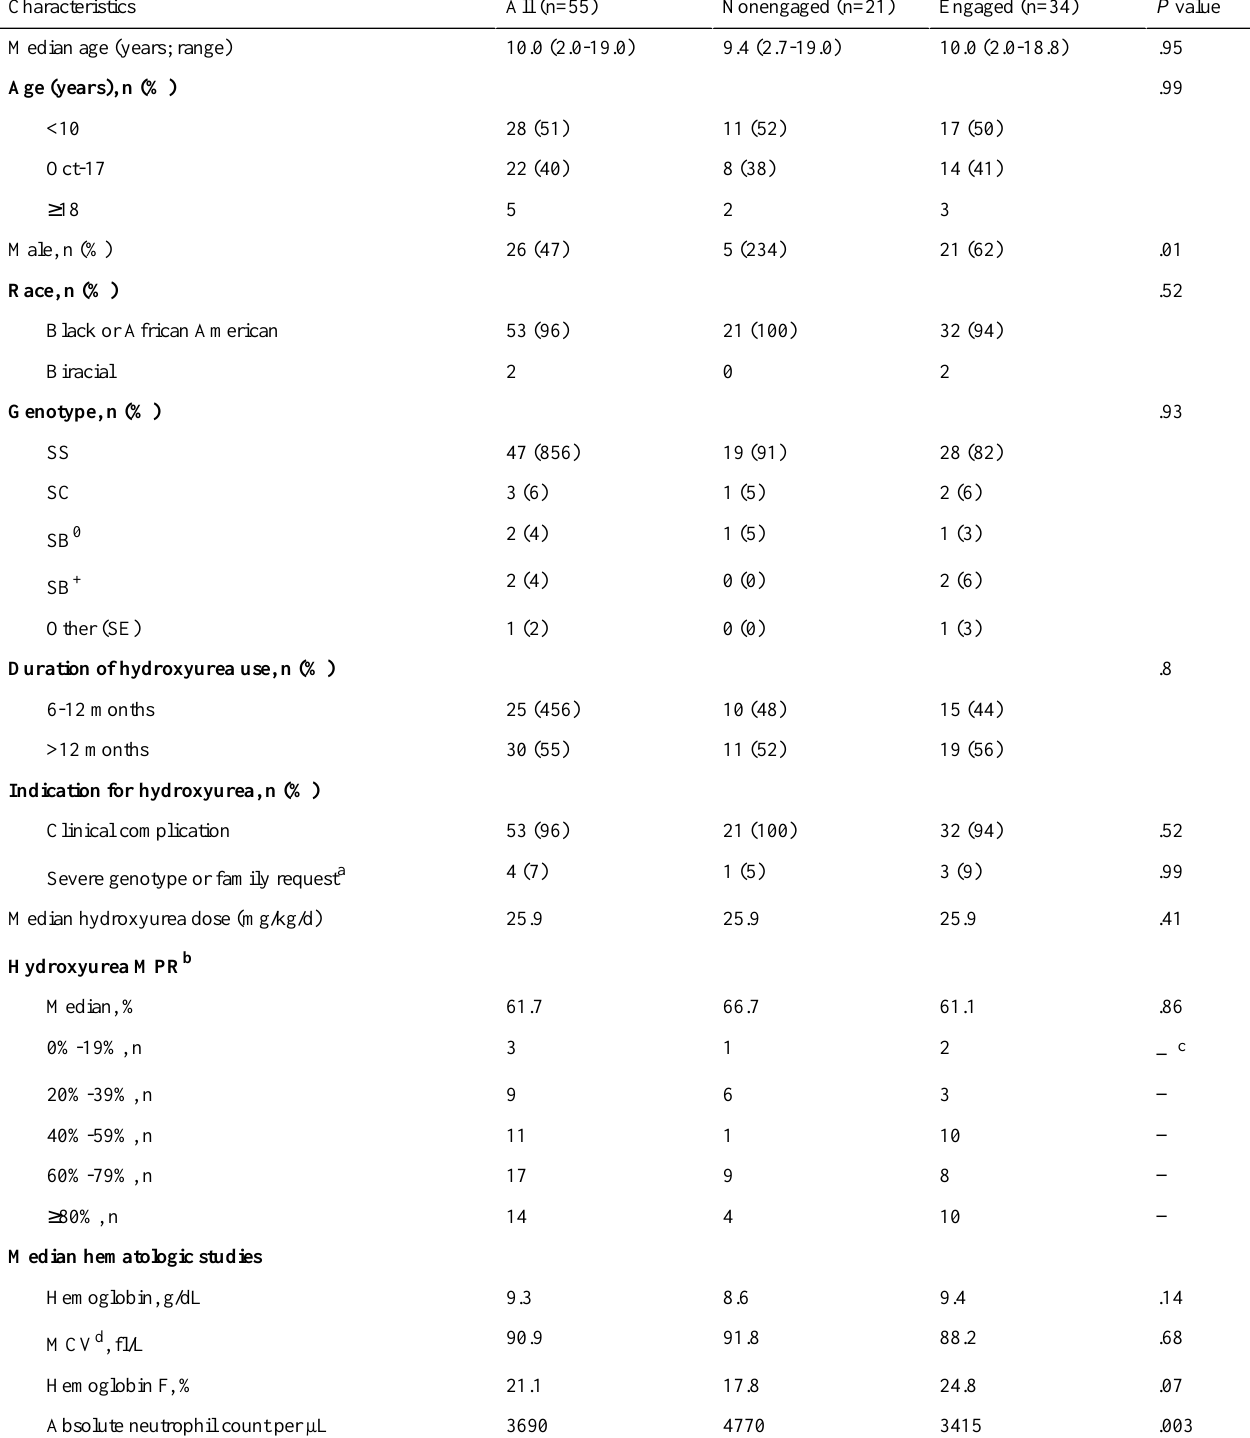
Table 1. Participants’baseline